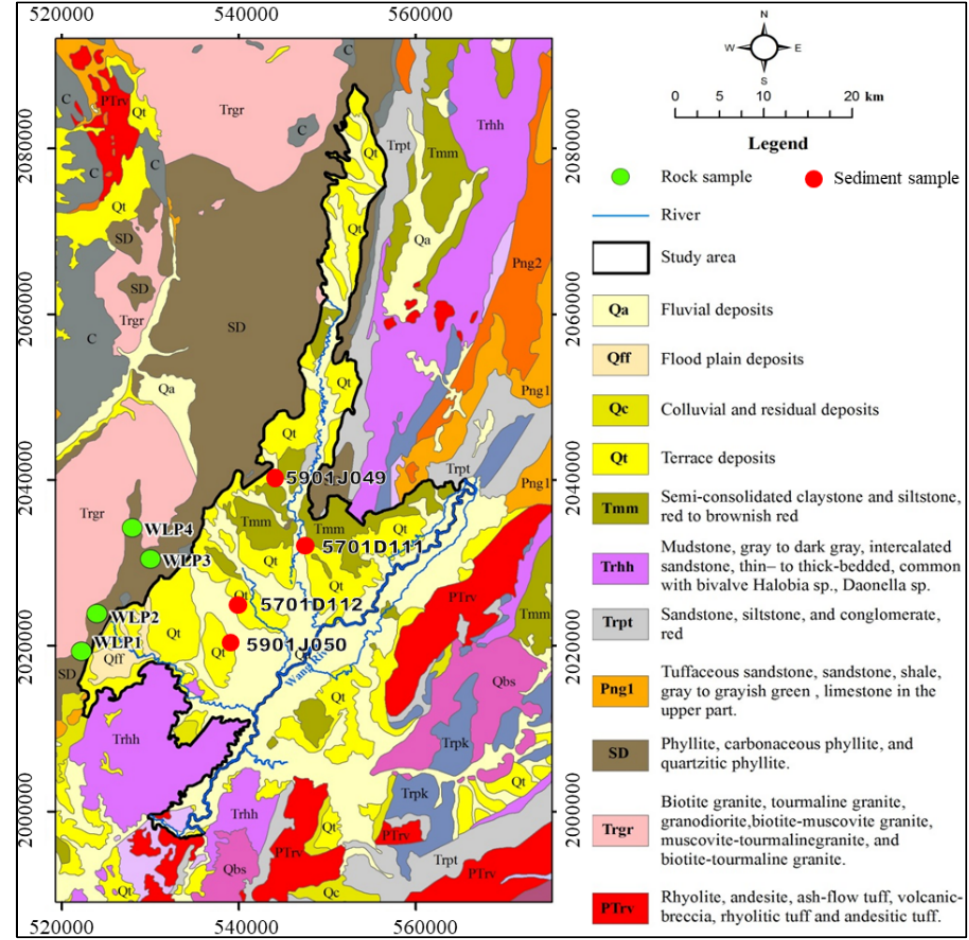
Figure 4. Sediment and rock sampling locations in the western part of the Lampang Basin.